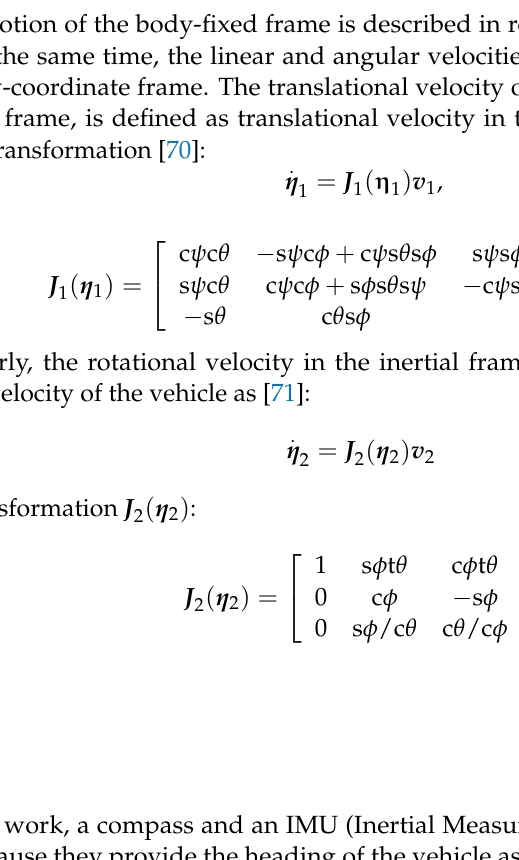
Figure 10. Body-fixed and inertial